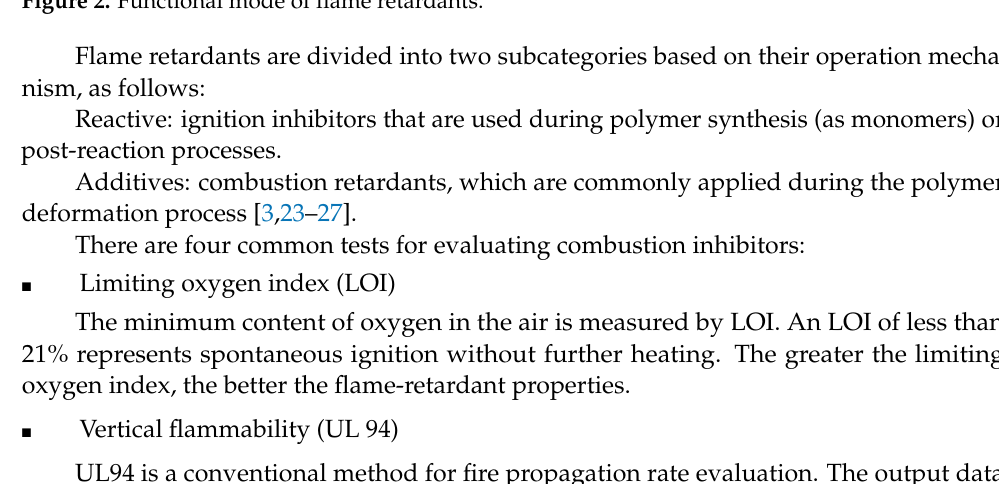
Figure 2. Functional mode of flame